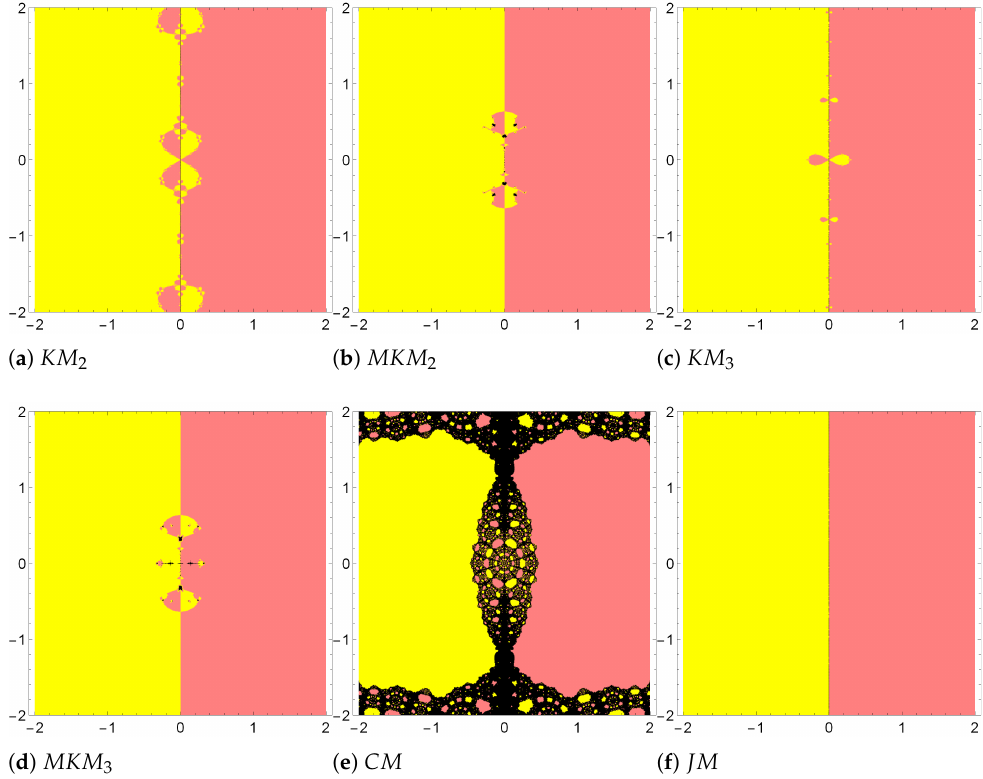
Figure 3. Dynamical planes of new and existing methods for Example 5.